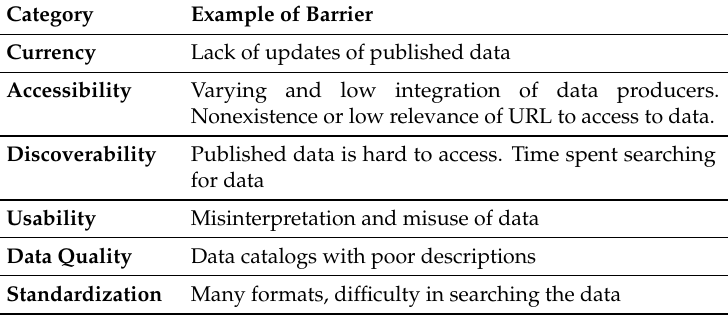
Table 7. Summary of most mentioned category barriers by data users along the used questions in the online